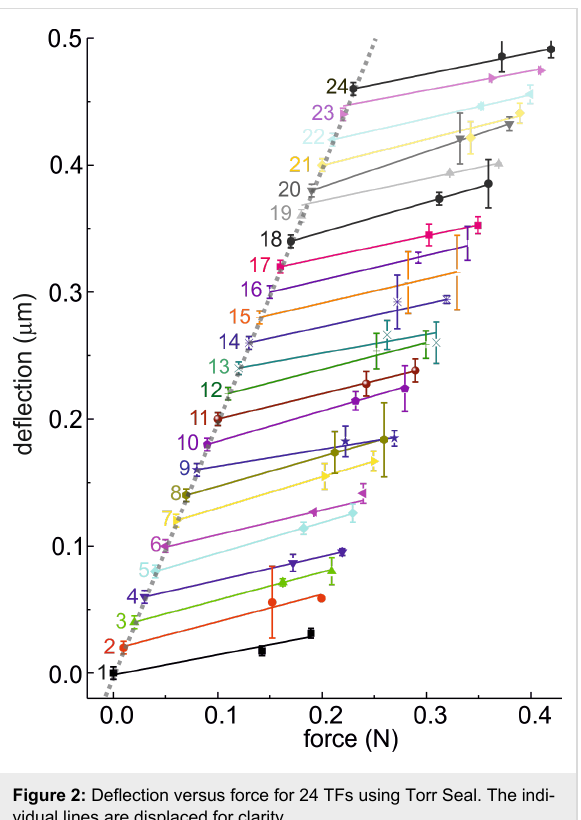
Figure 2: Deflection versus force for 24 TFs using Torr Seal. The indi- vidual lines are displaced for clarity.